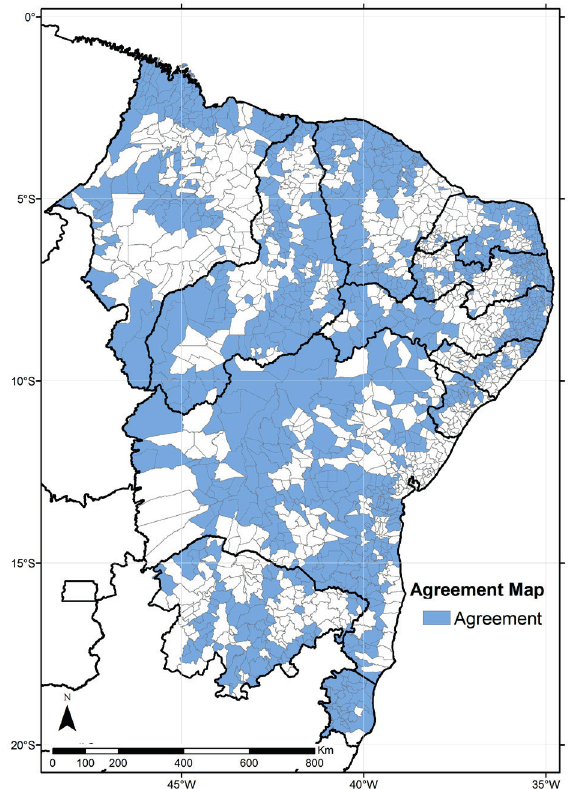
Figure 9 - Agreement spatial pattern (blue polygons), considering the drought monitoring